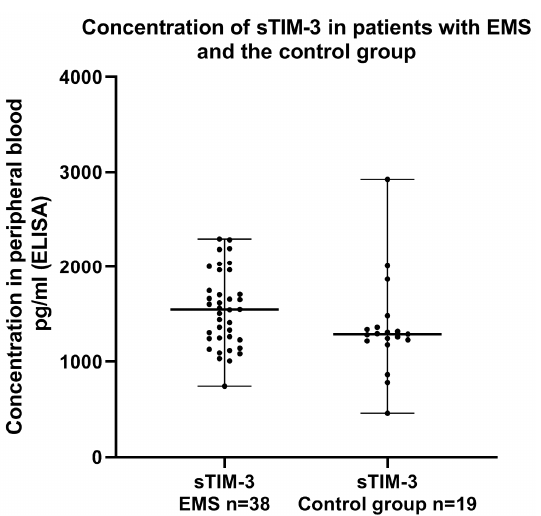
Figure 8. Levels of sTIM-3 (pg/mL) in the plasma of patients with endometriosis and the control group.